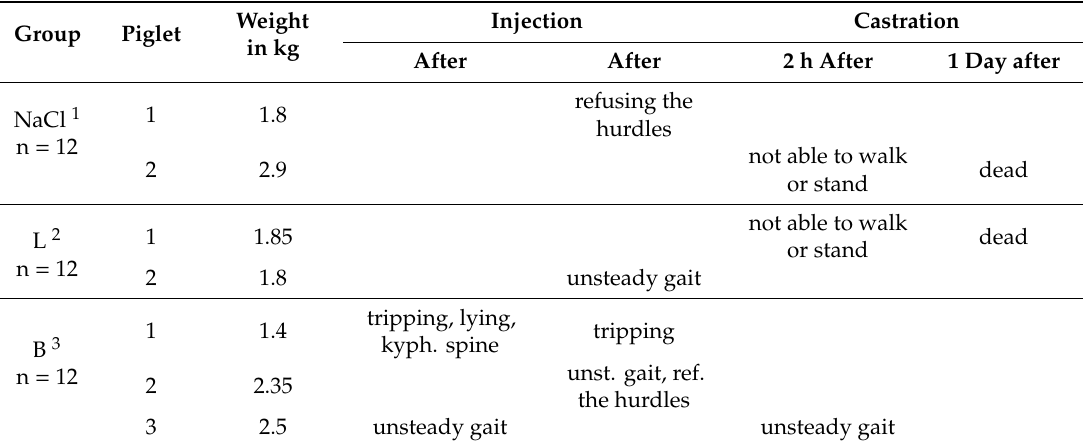
Table 5. Impairments of locomotor activity at di ff erent times of individual piglets. Weight Injection Castration Group Piglet in kg After After 2 h After 1 Day after refusing the 1 1.8 NaCl 1 hurdles n = 12 not able to walk dead 2 2.9 or stand not able to walk dead 1.85 or stand 1.8 unsteady gait tripping, lying, tripping 1.4 kyph. spine unst. gait, ref. 2 2.35 the hurdles 3 2.5 unsteady gait unsteady